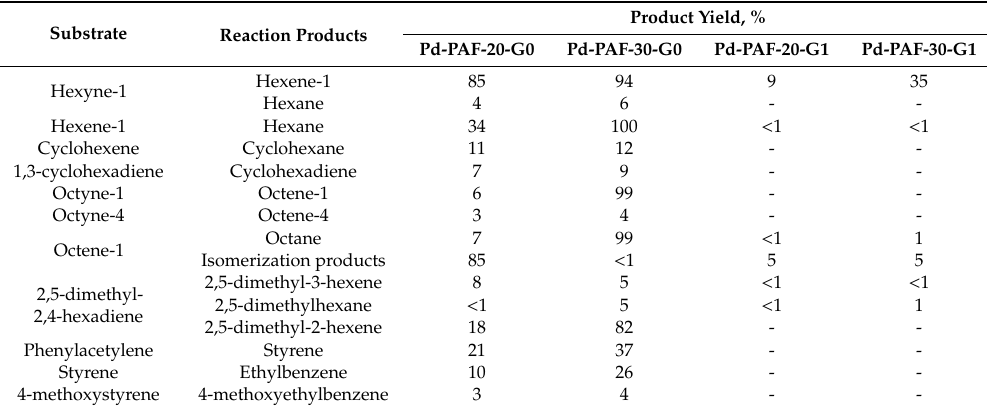
Table 6. Hydrogenation of unsaturated hydrocarbons on palladium catalysts.